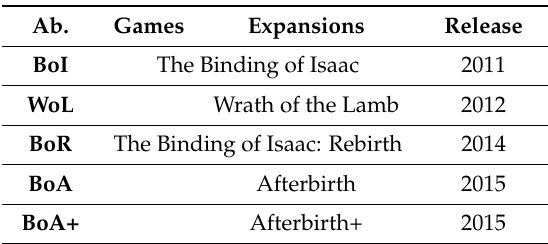
Table 1. Versions of the Binding of Isaac